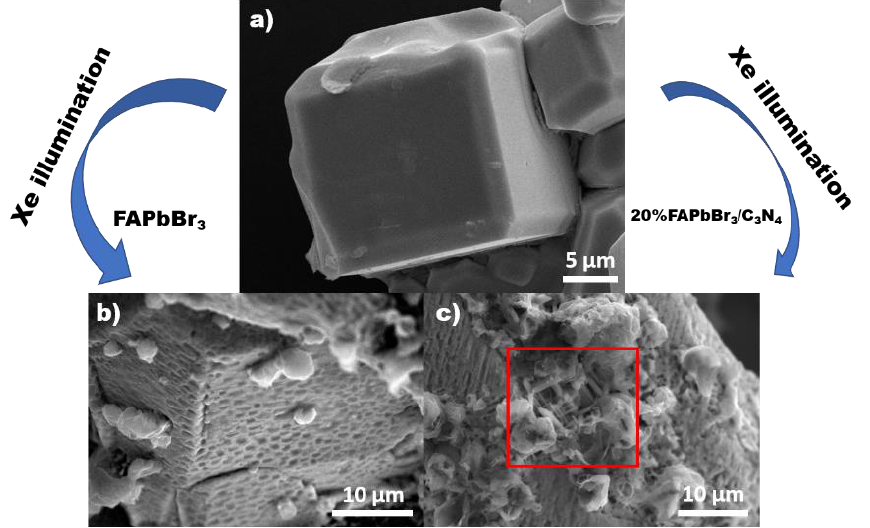
Figure 8. SEM image of ( a ) FAPbBr 3 crystals prepared at 25 °C using anti-solvent method; ( b ) pristine FAPbBr 3 crystals after the photocatalytic oxidation of benzylic alcohol; ( c ) FAPbBr 3 crystals after the photocatalytic oxidation of benzylic alcohol when g-C 3 N 4 is present.